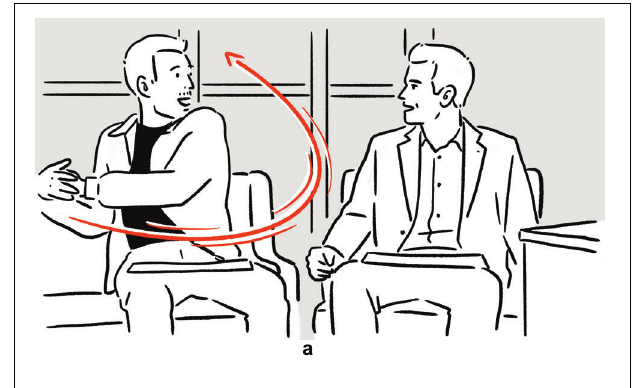
FIGURE 9 | Depiction in